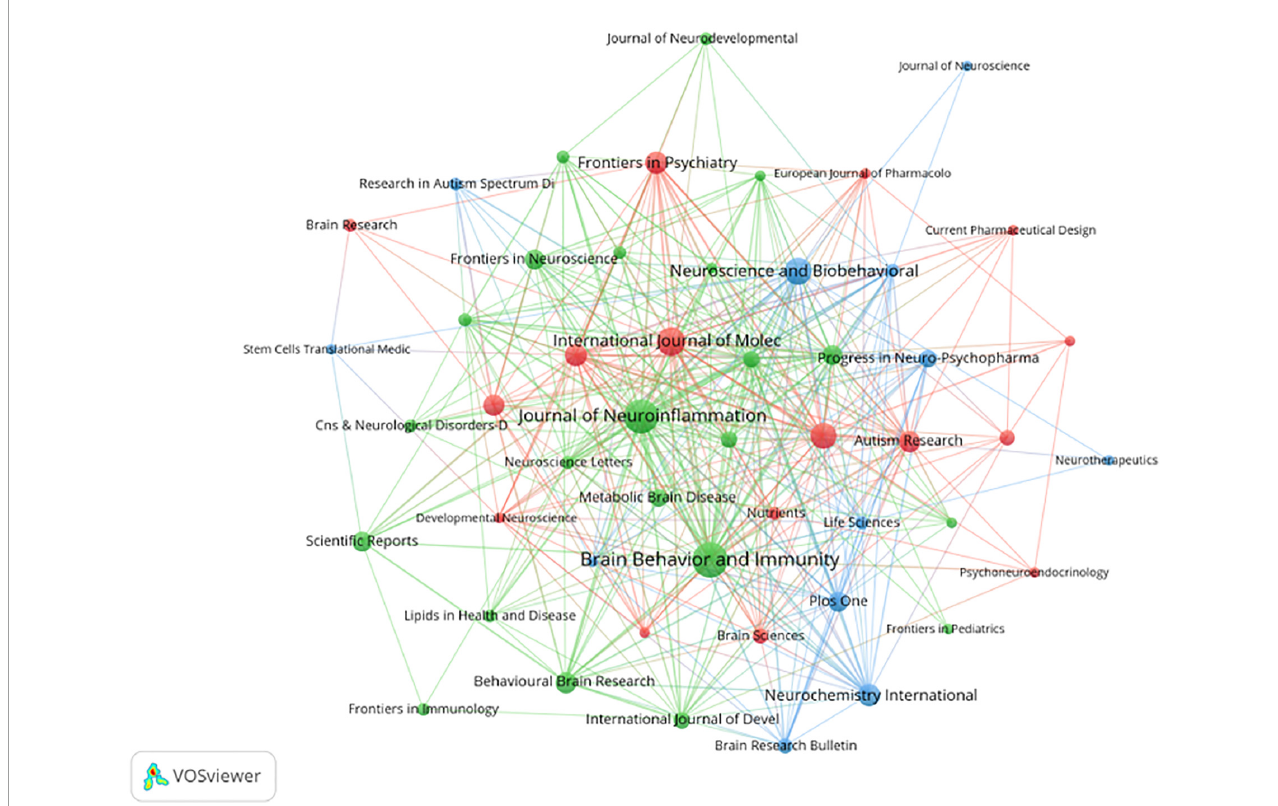
FIGURE5 The cooperation network visualization map of journals based on VOSviewer: The thickness of the line represents the strength of cooperation between journals.